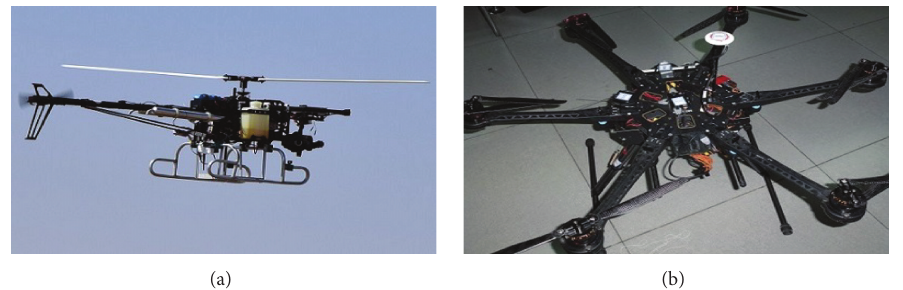
Figure 2: The photos of the single-rotor UAV and the six-rotor